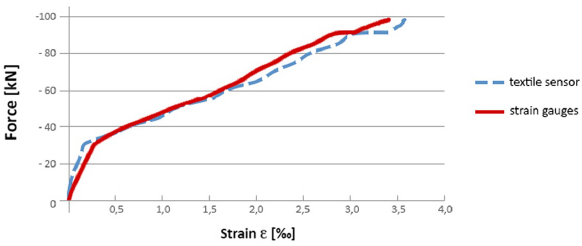
Figure 6: Comparison of average strain measured with the use of smart-textile prototype and system of typical strain gauges.